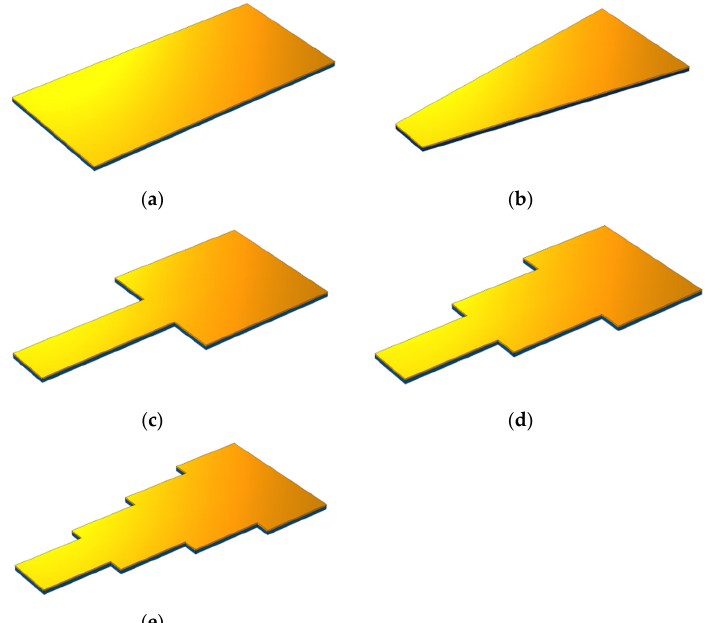
Figure 2. Different geometries of a cantilever beam: ( a ) rectangular, ( b ) trapezoidal, ( c ) two-step, ( d ) three-step, and ( e ) four-step geometries.